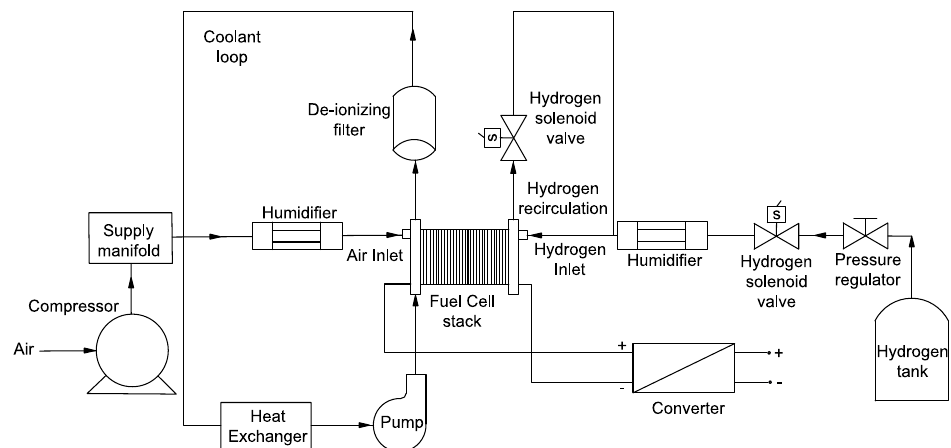
Figure 1. A schematic of the required system to obtain the I-V characteristic curves in contaminated and non-contaminated PEMFCs. and non-contaminated